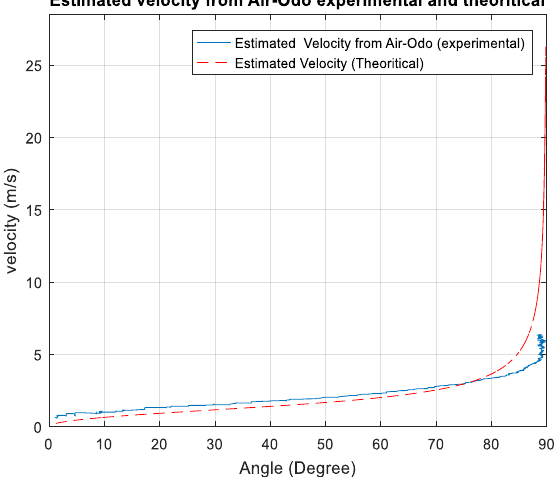
Figure 9. Experimental relationship between wind velocities and Air-Odo angles and theoretical relation.